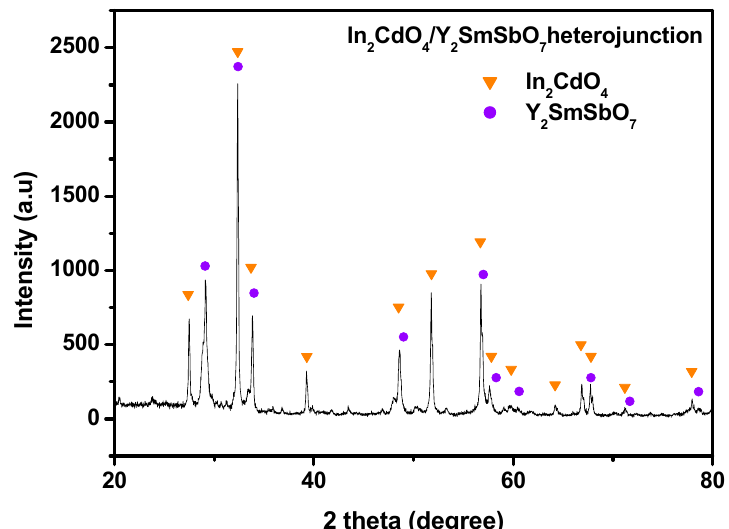
Figure 3. The X − ray di ff raction spectrum of In 2 CdO 4 /Y 2 SmSbO 7